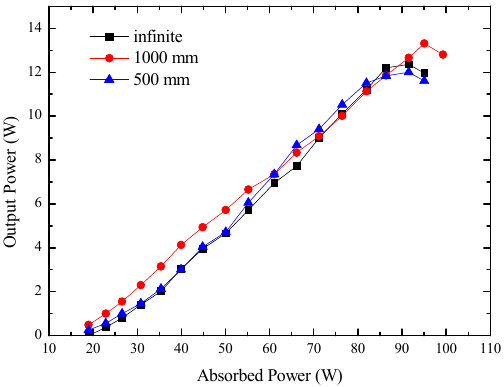
Figure 4. Output power of the Nd:YAG SCF laser with four different OCs; (Curvature radius: 1000, 500, 200 and 100 mm).